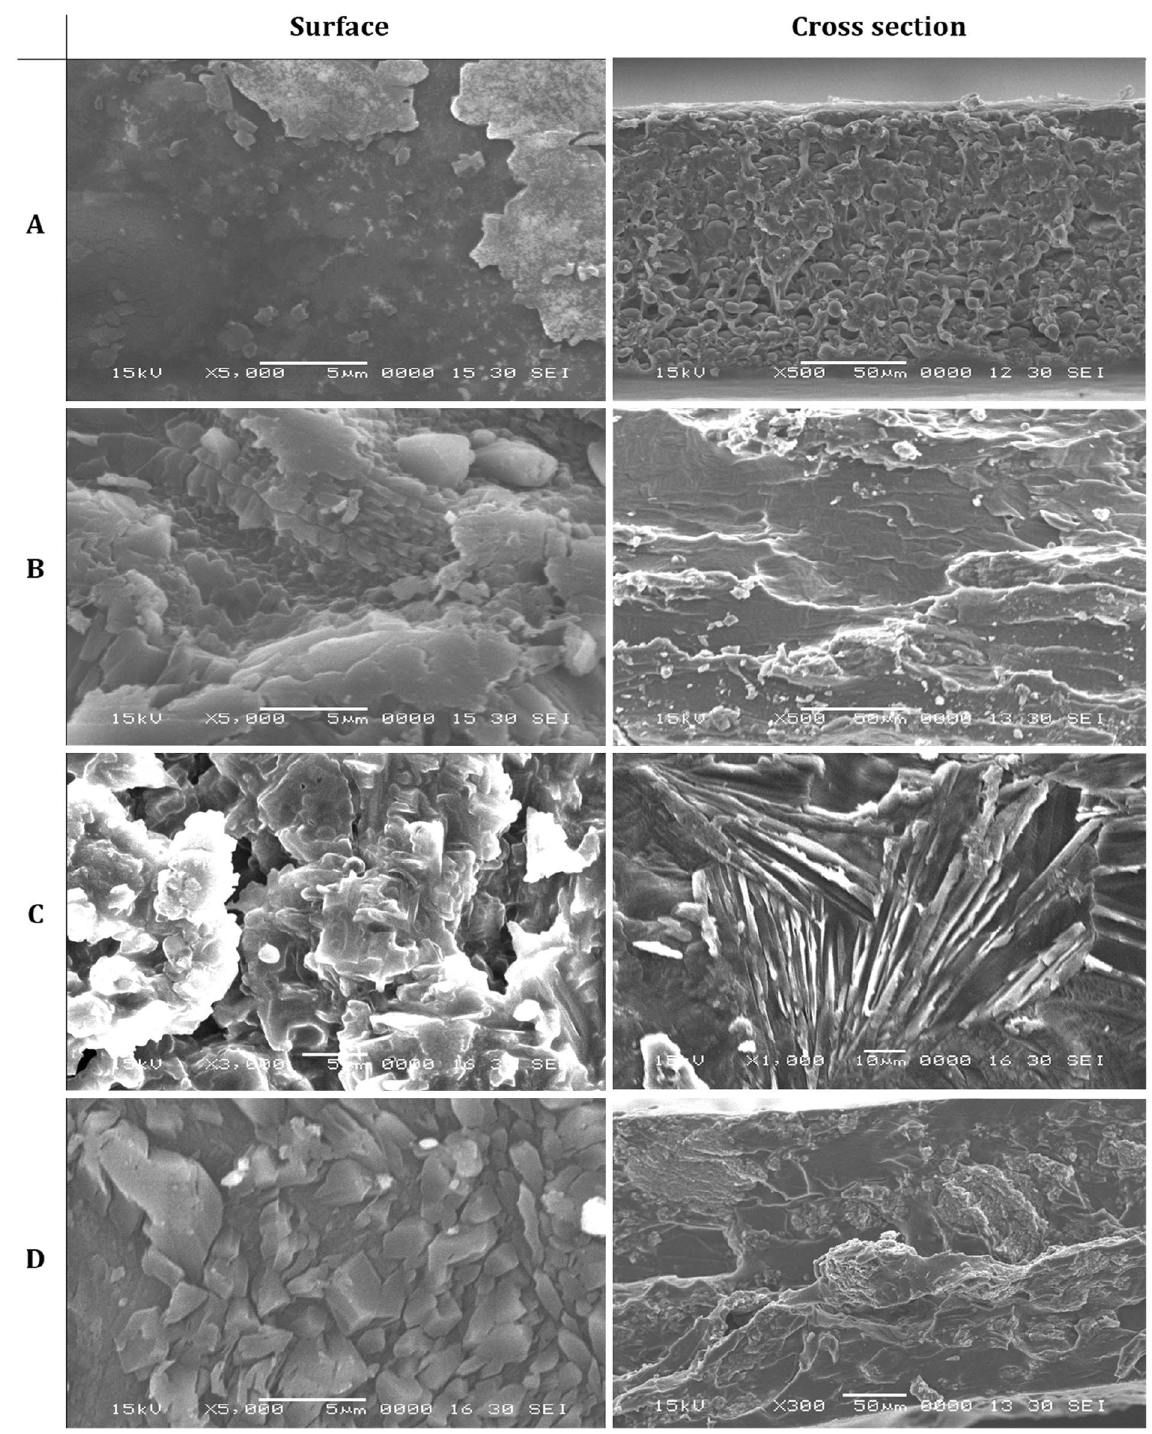
Figure 3. SEM micrographs of surface and cross-section of CMC/PVA/AA and modified CMC/PVA/AA based hybrid polyelectrolytic membranes. ( A ) pristine CMC/PVA/AA membrane. ( B ) CMC/PVA/AA-(4%) CSA. ( C ) CMC/PVA/AA-(4%) CSA-(2%) CCNT. ( D ) CMC/PVA/AA-(4%) CSA-(2%)